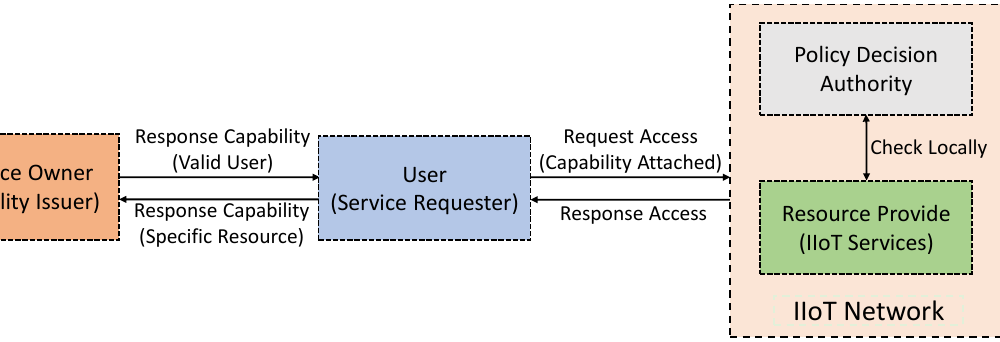
Figure 8. A simple outline of a DCapBAC process discussed in